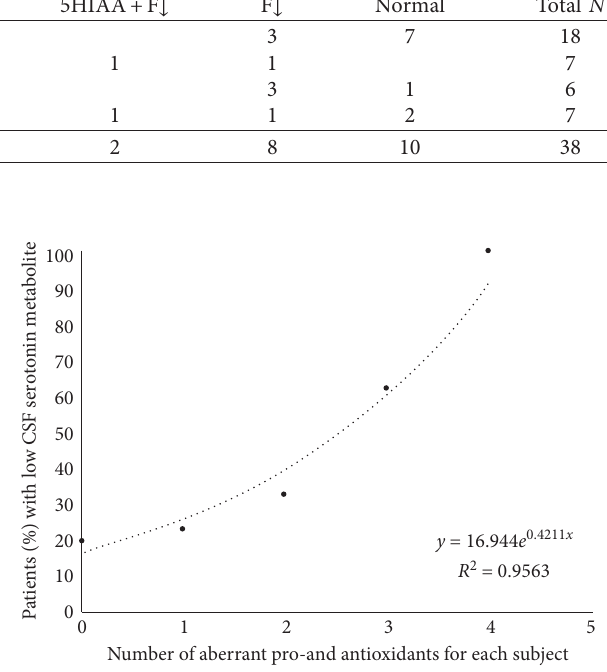
Figure 4: The relationship between the serotonin metabolite 5HIAA concentration and redox status. This plot shows the cu- mulative number of antioxidant deficiencies or increased pro- oxidants on the X -axis and the percentage of patients with low CSF 5HIAA metabolites on the Y -axis, representing the end metabolite of serotonin production.